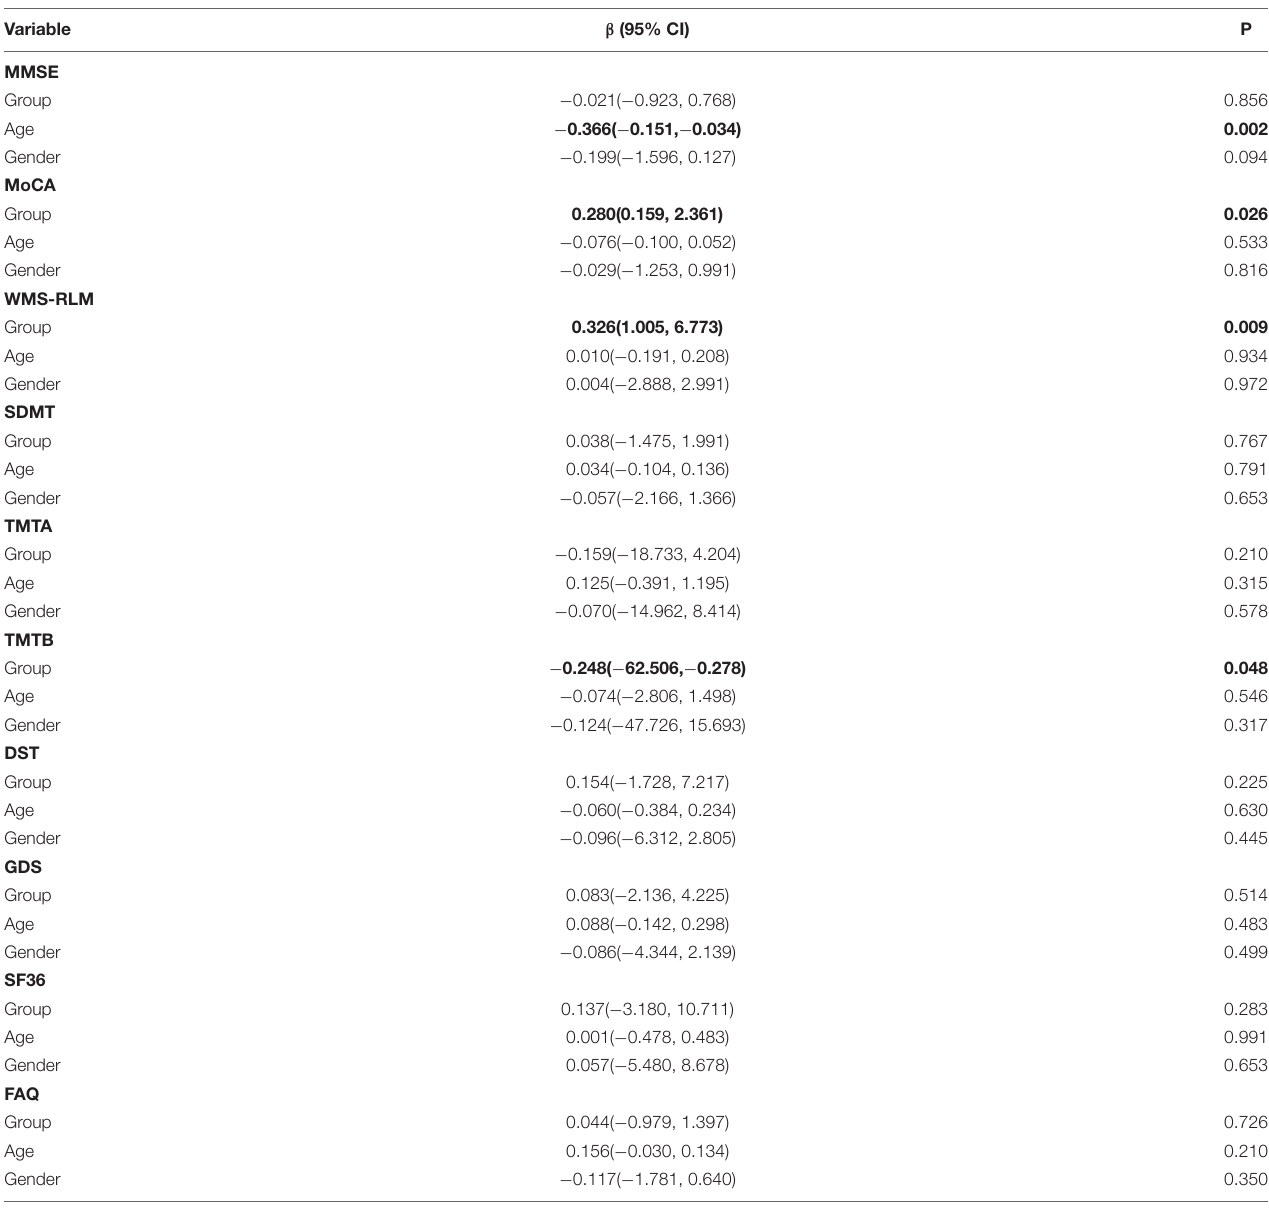
TABLE 3 | Linear regression of clinical assessments and its potential